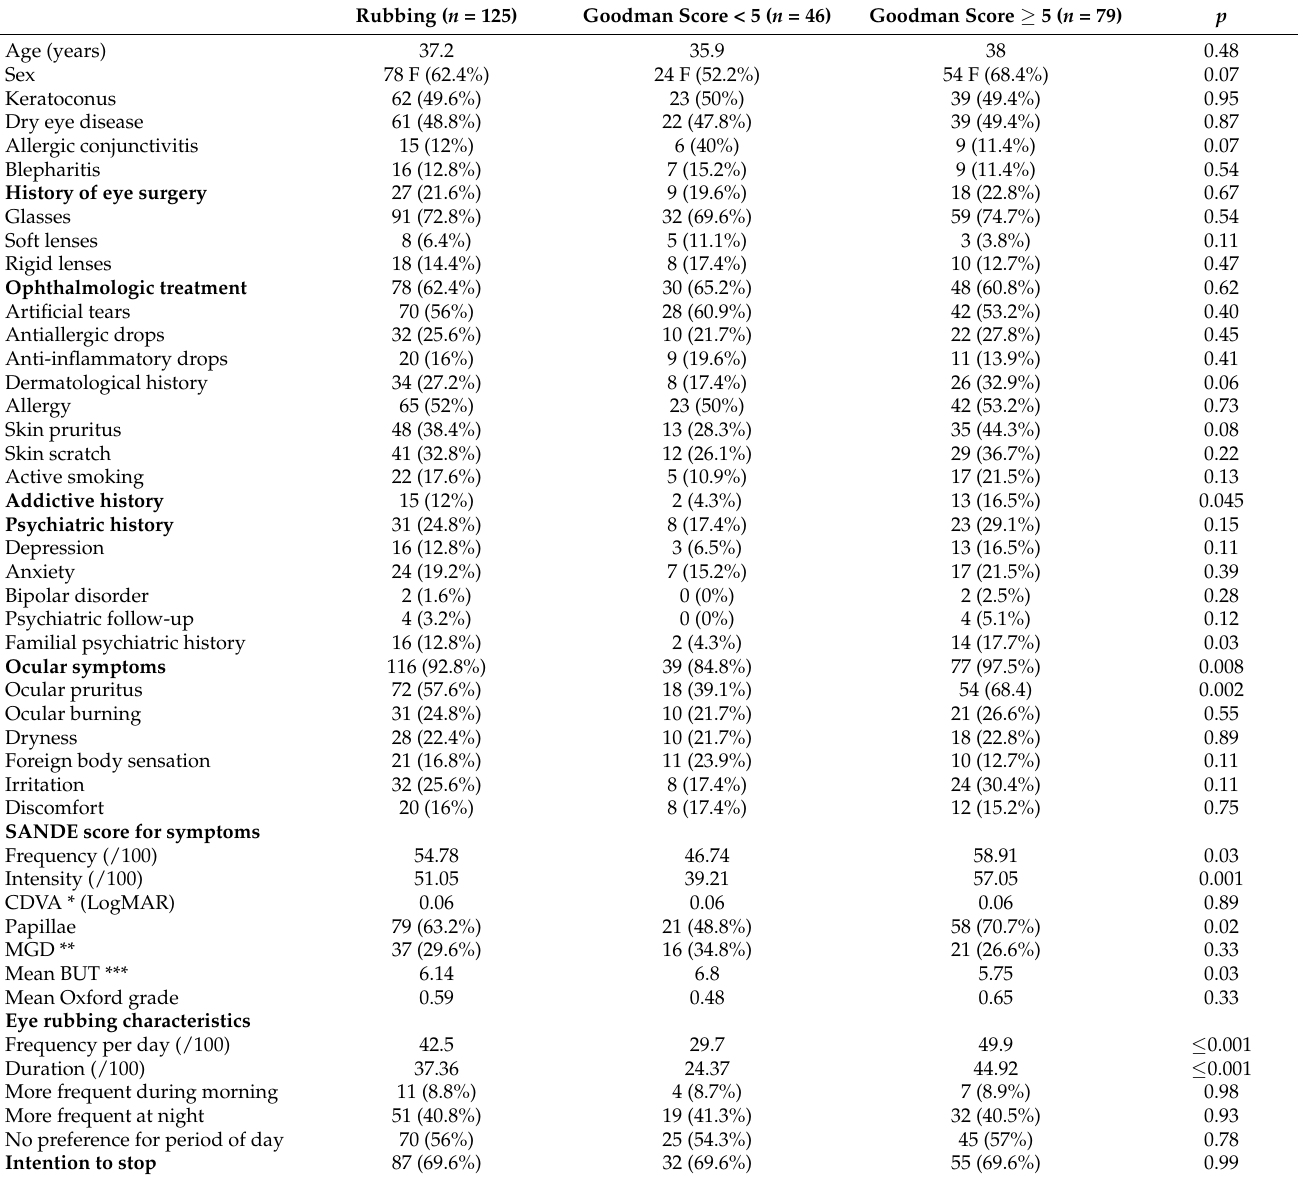
Table 4. Comparison of patients according to Goodman’s criteria